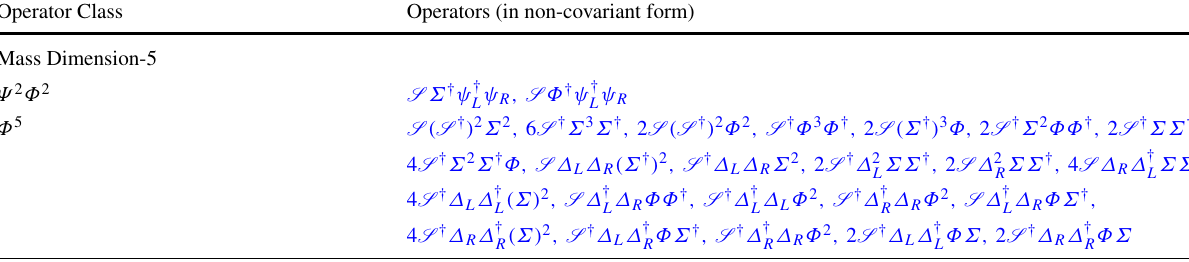
Table 9 Pati-Salam model: operators of mass dimension-5 Operator